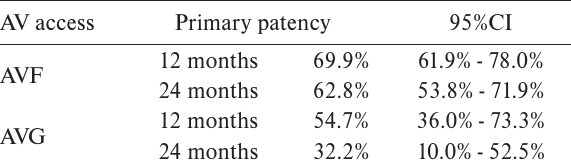
Table 1. Primary patency of all AV accesses.